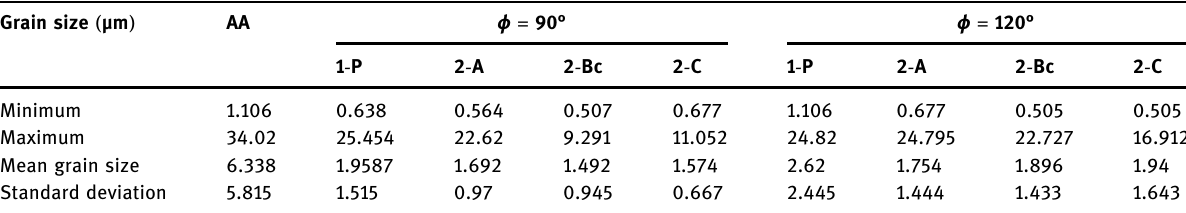
Table 1: Grain size data ( µm ) of all Mg specimens grouped by die angle ( ϕ ) and route type Grain size ( µm ) AA ϕ = 90°